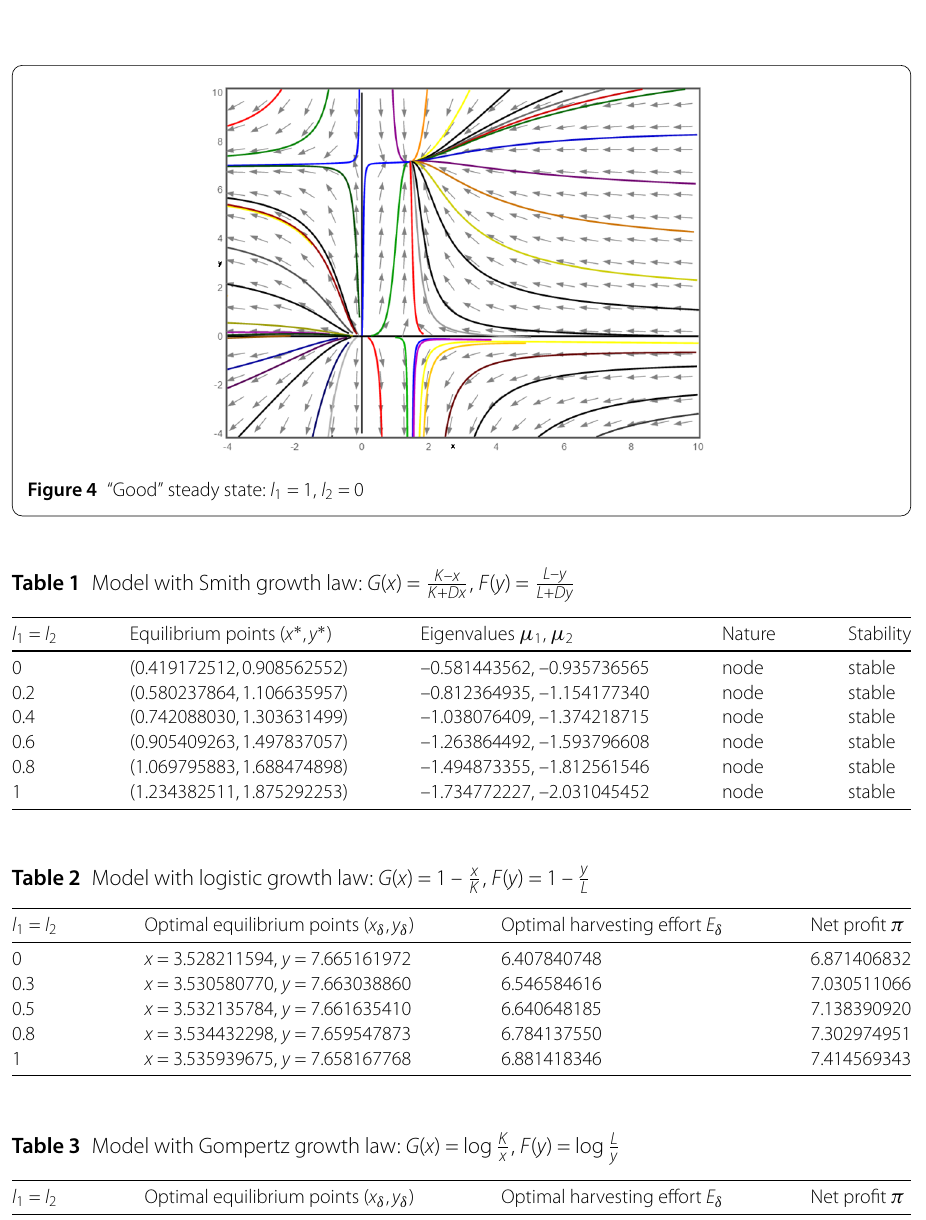
Table 3 Model with Gompertz growth law: G ( x ) = log K